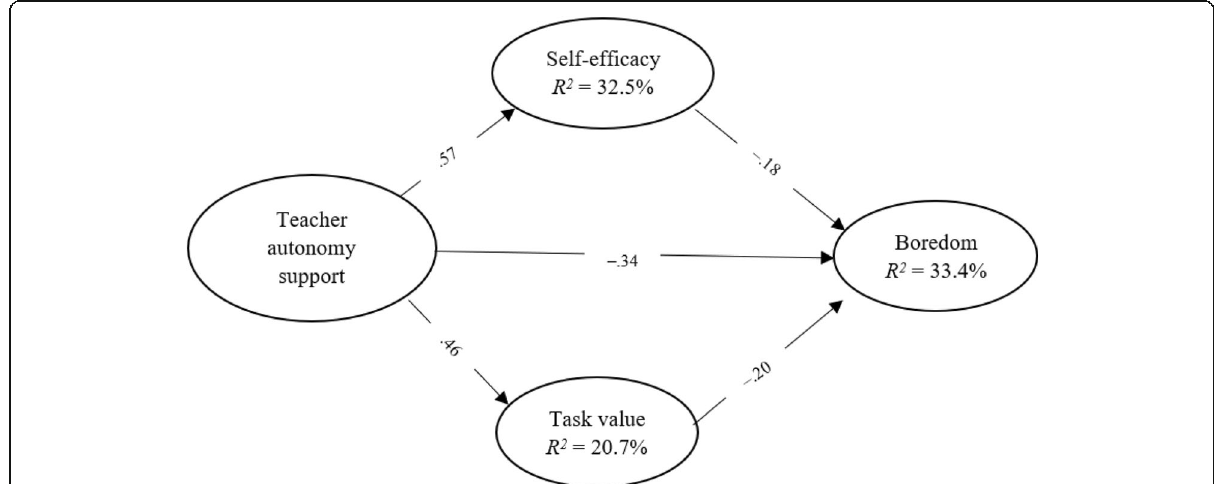
Fig. 3 Partial mediation model with latent variables showing standardised beta correlation coefficients ( β ) and coefficients of determination ( R 2